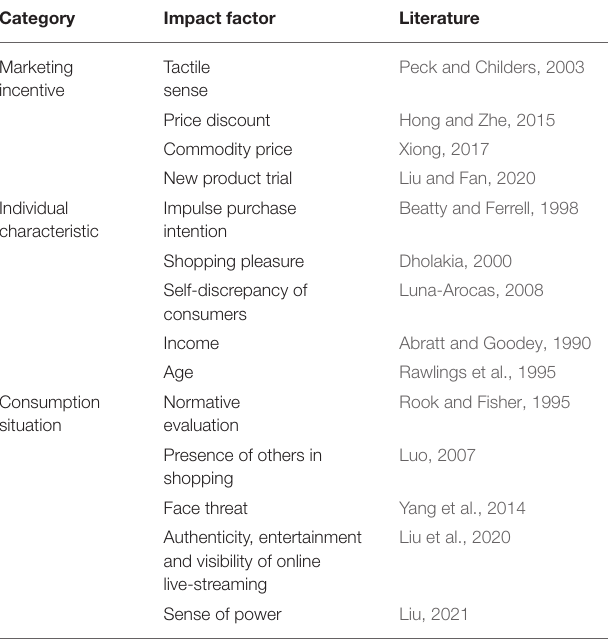
TABLE 1 | Impact factors of impulse